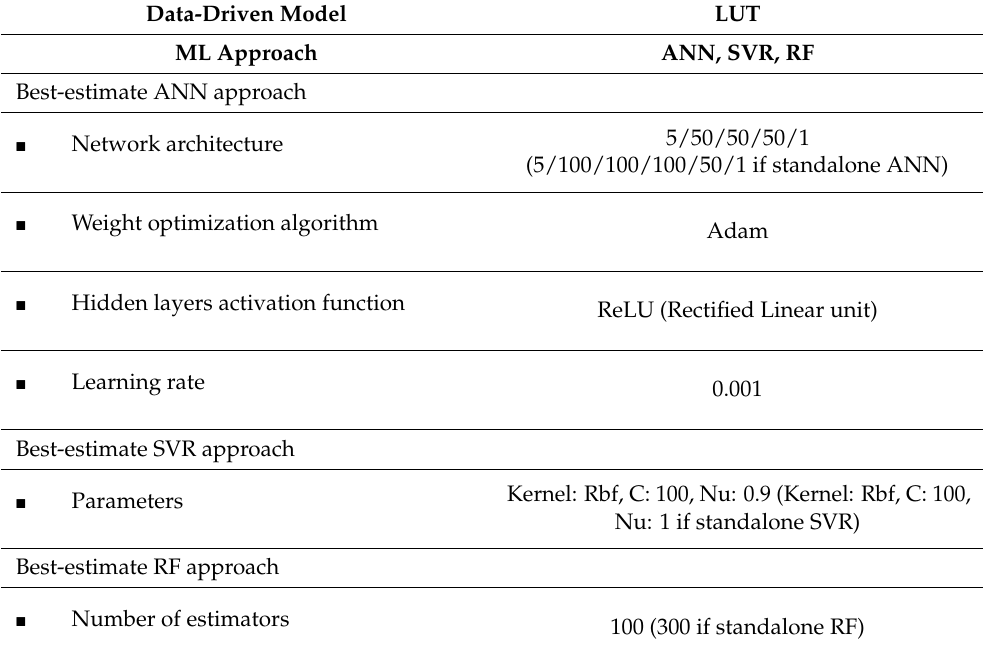
Table 2. Configuration of CHF